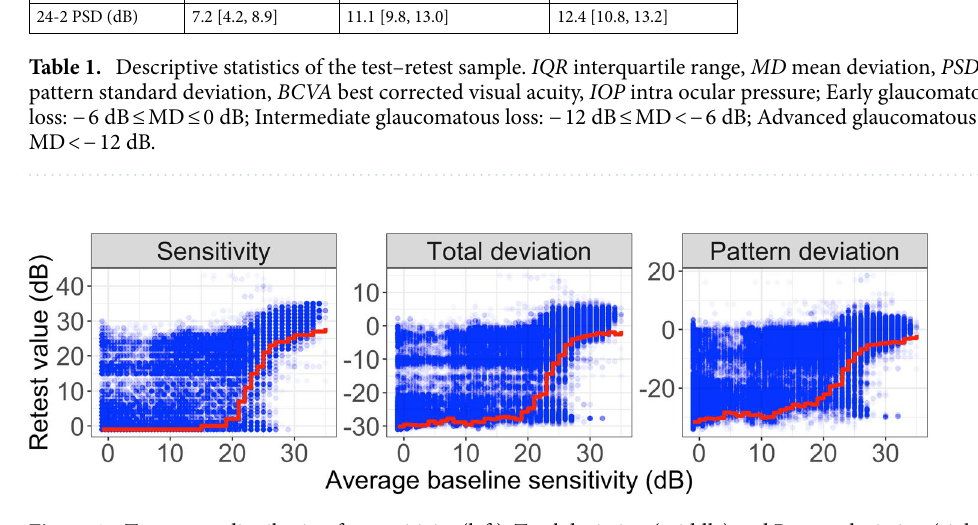
Figure 1. Test–retest distribution for sensitivity (left), Total deviation (middle) and Pattern deviation (right) values stratified by baseline sensitivities values (average of two tests). The red lines show the lower 5% limits derived for each baseline sensitivity